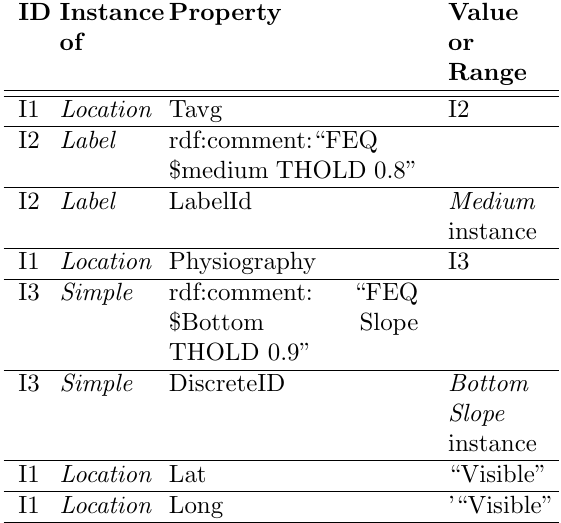
Table 4. Instances of a query definition in the domain ontology of the land characteristics